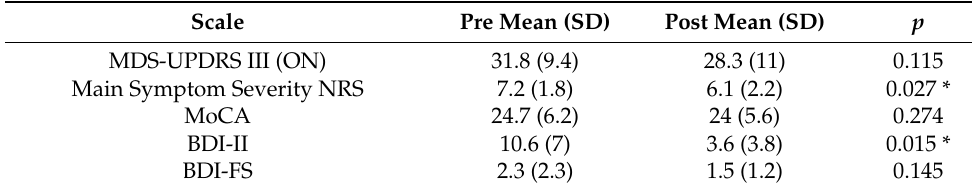
of the assessments that were used. A significant effect was shown in the depressive score using the BDI-II questionnaire and in the subjective main symptom using the NRS. A trend for improvement can be seen in the UPDRS ON and